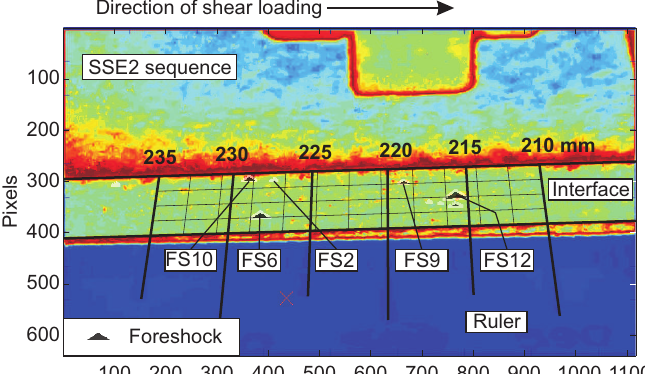
Figure 12. Images from the video camera at frame F constructed using image-processing software, and foreshock locations were superimposed on each image. Shear loading was from left to